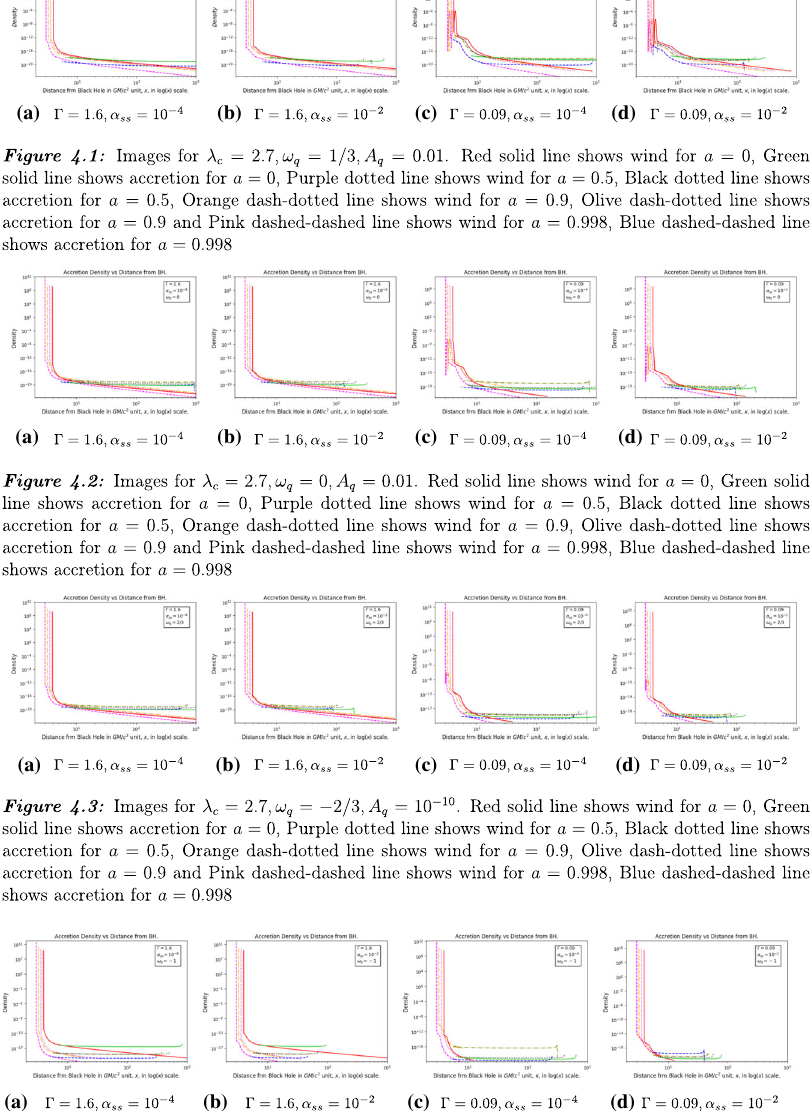
4.3 Images for λ c = 2 . 7 ,ω q = − 2 / 3 , A q = 10 − 10 . Red solid line Fig. 4 Curves for η/ s vs radial distance from BH. 4.1 Images for λ = 2 . 7 ,ω = 1 / 3 , A = 0 . 01. Red solid line shows wind for a = 0, shows wind for a = 0, Green solid line shows accretion for a = 0, Pur- c q q ple dotted line shows wind for a = 0 . 5, Black dotted line shows accre- Green solid line shows accretion for a = 0, Purple dotted line shows tionfor a = 0 . 5,Orangedash-dottedlineshowswindfor a = 0 . 9,Olive windfor a = 0 . 5,Blackdottedlineshowsaccretionfor a = 0 . 5,Orange dash-dotted line shows accretion for a = 0 . 9 and Pink dashed-dashed dash-dotted line shows wind for a = 0 . 9, Olive dash-dotted line shows line shows wind for a = 0 . 998, Blue dashed-dashed line shows accre- accretion for a = 0 . 9 and Pink dashed-dashed line shows wind for a = 0 . 998, Blue dashed-dashed line shows accretion for a = 0 . 998. 4.2 tion for a = 0 . 998. 4.4 Images for λ c = 2 . 7 ,ω q = − 1 , A q = 10 − 10 . Images for λ c = 2 . 7 ,ω q = 0 , A q = 0 . 01. Red solid line shows wind Red solid line shows wind for a = 0, Green solid line shows accretion for a = 0, Purple dotted line shows wind for a = 0 . 5, Black dotted line for a = 0,Greensolidlineshowsaccretionfor a = 0,Purpledottedline shows accretion for a = 0 . 5, Orange dash-dotted line shows wind for shows wind for a = 0 . 5, Black dotted line shows accretion for a = 0 . 5, a = 0 . 9, Olive dash-dotted line shows accretion for a = 0 . 9 and Pink Orange dash-dotted line shows wind for a = 0 . 9, Olive dash-dotted line dashed-dashedlineshows windfor a = 0 . 998, Bluedashed-dashedline shows accretion for a = 0 . 9 and Pink dashed-dashed line shows wind shows accretion for a = 0 . for a = 0 . 998, Blue dashed-dashed line shows accretion for a = 0 . 998.